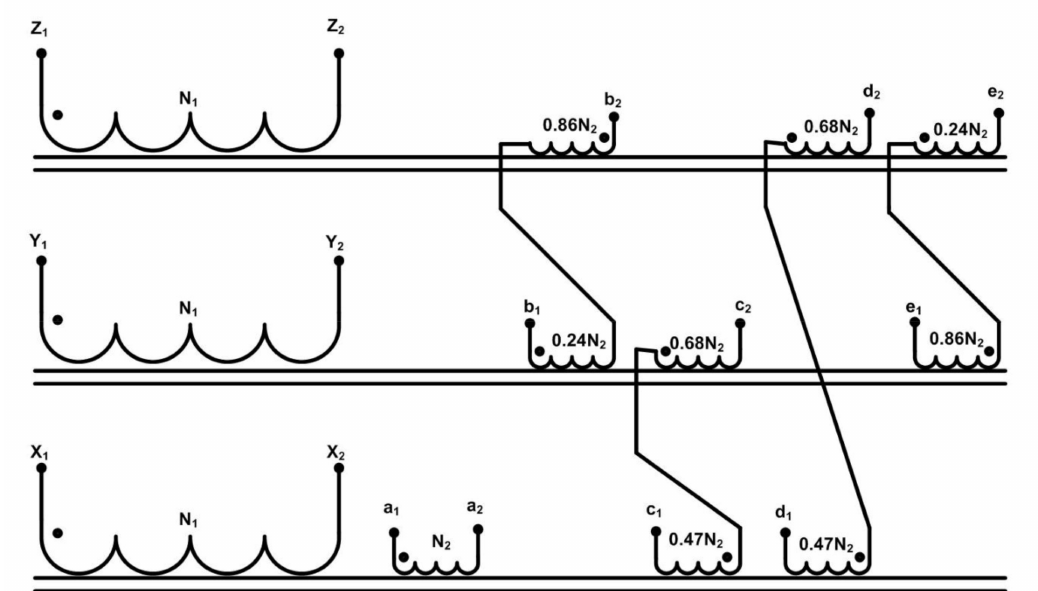
Figure 6. Configuration 2 for a three-phase to the five-phase